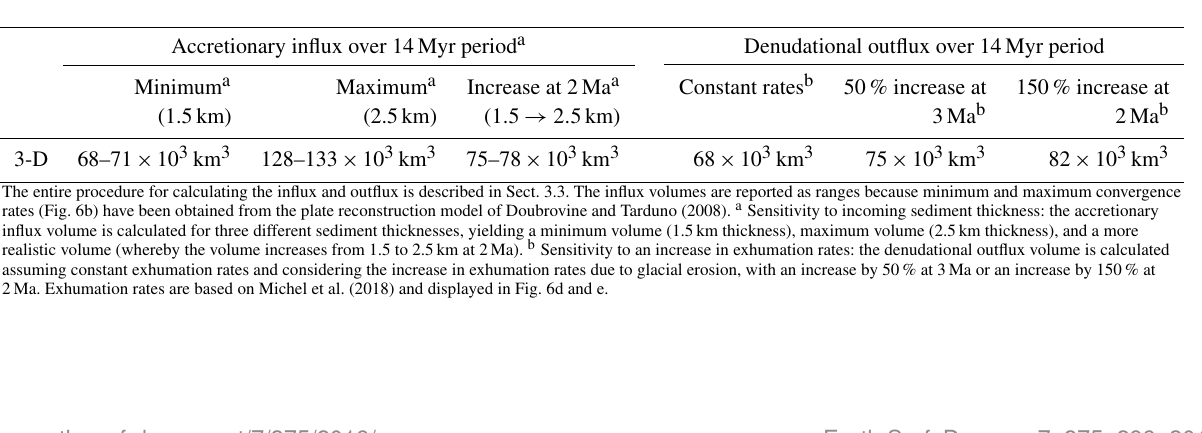
Figure 6. Constraints used for our quantitative accretionary influx and denudational outflux calculations. (a) Cartoon illustrating our ap- proach for calculating the accretionary influx. The influx corresponds to the sediment scraped off the subducting Juan de Fuca Plate and is governed by the plate convergence rate ( u ) and the incoming sediment properties (thickness d , porosity η ). Because we use a three- dimensional geometry, accretion is considered along a length ( l ) within a vertical plane. This length corresponds to the length of the coastline indicated in panel (d) . OM: Olympic Mountains, CRT: Coast Range Terrane. After Batt and Brandon (2002). (b) Temporal evolution of the plate convergence rate used in the calculations, considering only the component perpendicular to the deformation front (black envelope), and the original output (blue envelope) from the plate reconstruction model of Doubrovine and Tarduno (2008). To provide an uncertainty for our calculations, we consider a range of convergence rates (comprising the width of the envelope) for each time step based on two different rotation models in the model of Doubrovine and Tarduno (2008) (see text for details). (c) Temporal evolution of the plate convergence angle (Doubrovine and Tarduno, 2008) used to correct the plate convergence rate in (b) . (d) Exhumation rate pattern from Michel et al. (2018) used for our outflux calculations. The range of displayed rates (0.25–0.9kmMyr − 1 ) corresponds to the rates prior to the glacially induced increase in exhumation rates. The outflux is based on the spatial integration of the exhumation rate pattern. Values for the integrals are listed below the plot for the respective increase in exhumation and time. The white dashed line was used for integrating the exhumation rate using a two-dimensional geometry, which is further explained in the Appendix. Table 5. Results from influx and outflux calculations using a three-dimensional